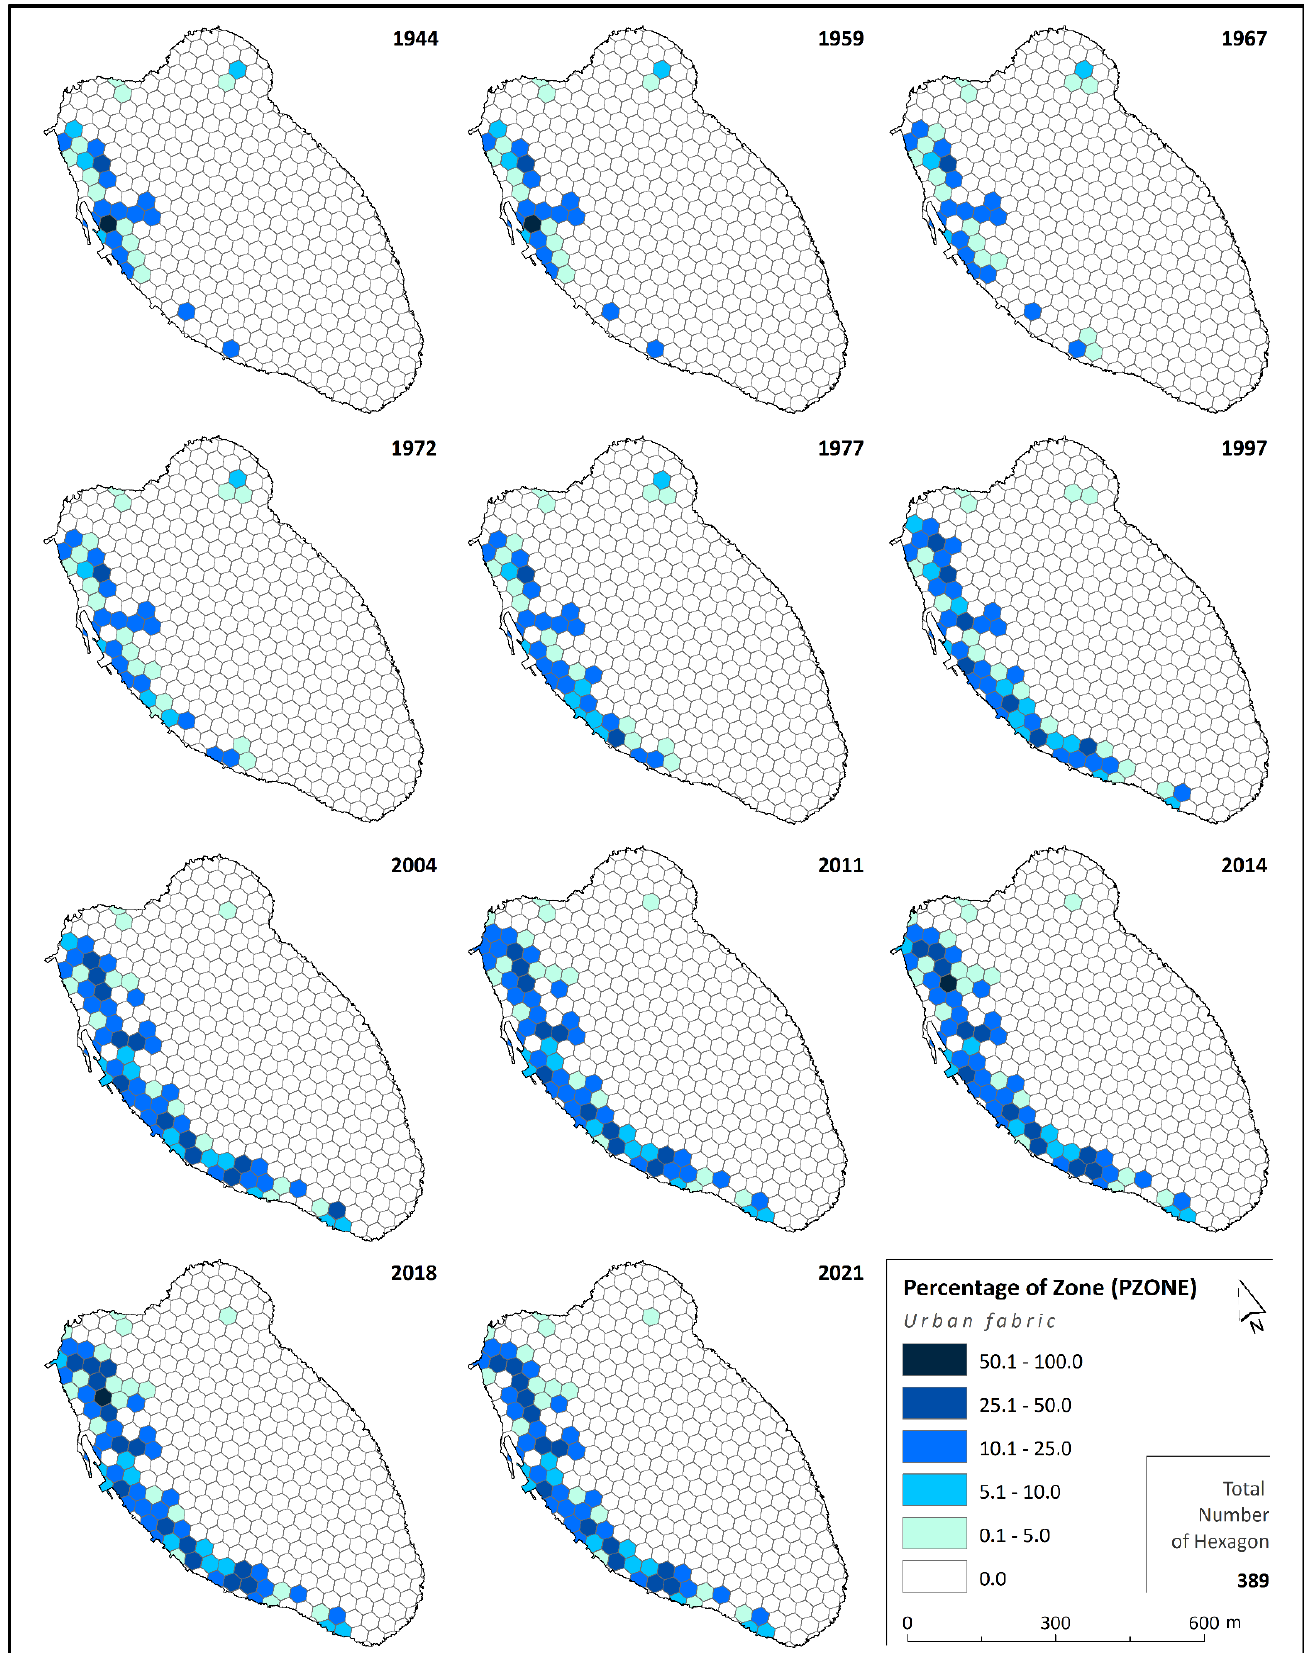
Figure 19. PZONE per zones for Ošljak (1944–2021)—urban.